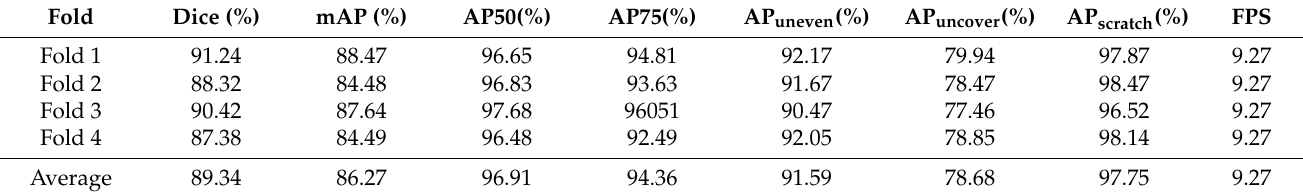
Table 7. Four-fold cross validation result, where FPS denotes for frame per second by using Mask- RCNN with ResNet 101 backbone. In total, the number of parameters Mask RCNN used is 69,188,563.